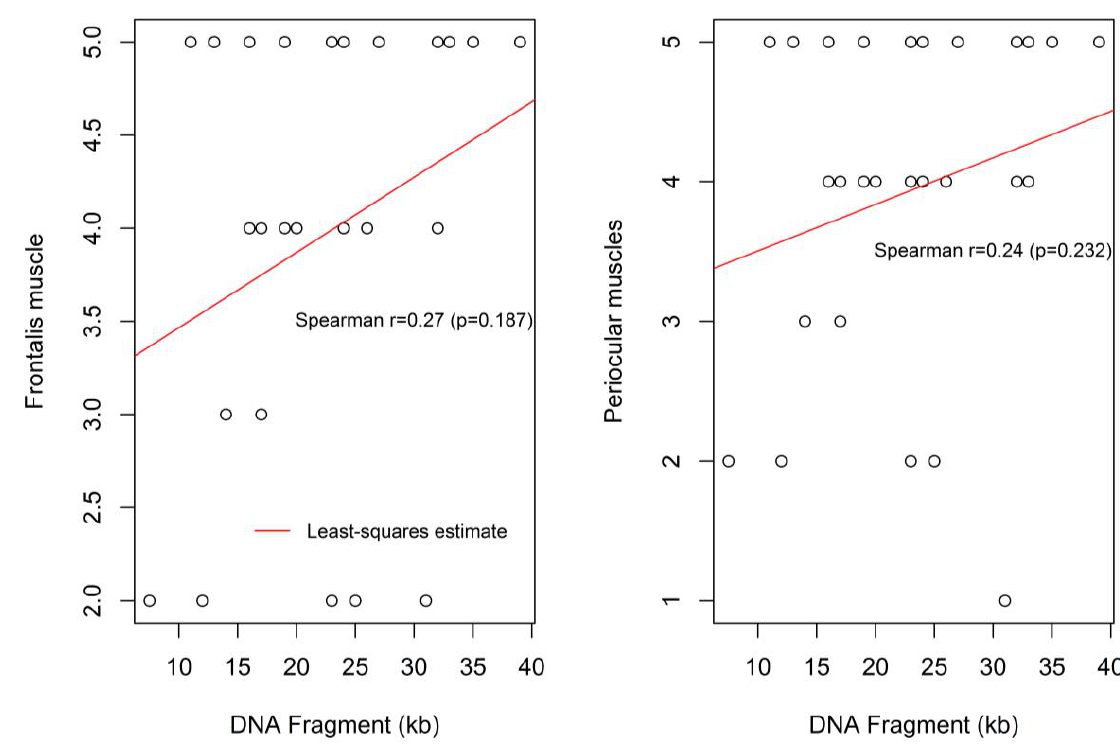
Figure 4. Correlation between the DNA fragment size and the severity of frontalis muscle weakness and the periocular muscle weakness.